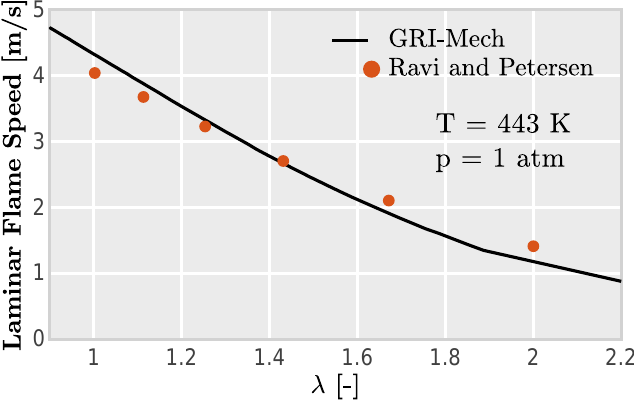
Figure 3. Validation of H 2 laminar flame speed for different air-to-fuel ratios.